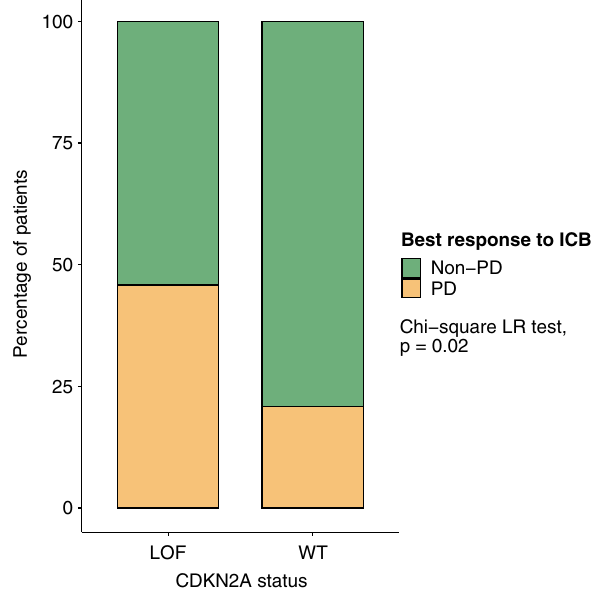
Figure 4. CDKN2A LOF and ICB response. Disease control rate (non-PD vs. PD) for CDKN2A wild-type (WT, N = 72) and loss-of-function (LOF, N = 24) tumors with evaluable lesions. Non-evaluable lesions could not be measured due to pleural effusions, interval lung collapse, and/or irregular lesion contours as per RECIST version 1.1